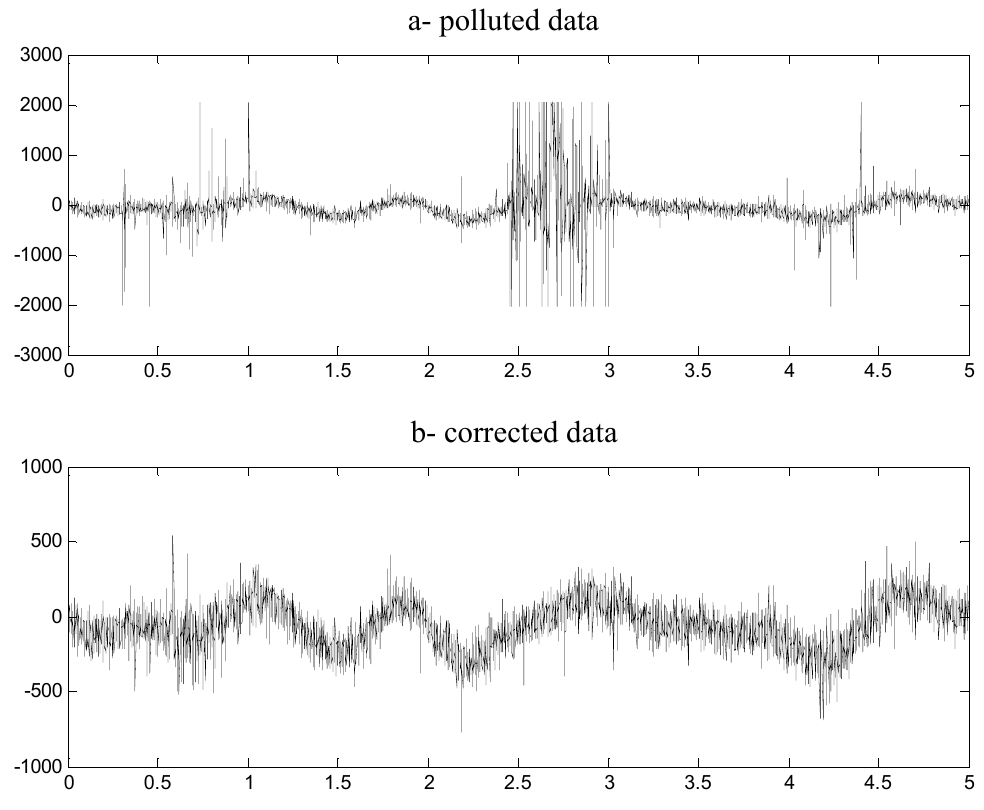
Fig. 3. Doppler radial velocity of wind and hydrometeor UHF